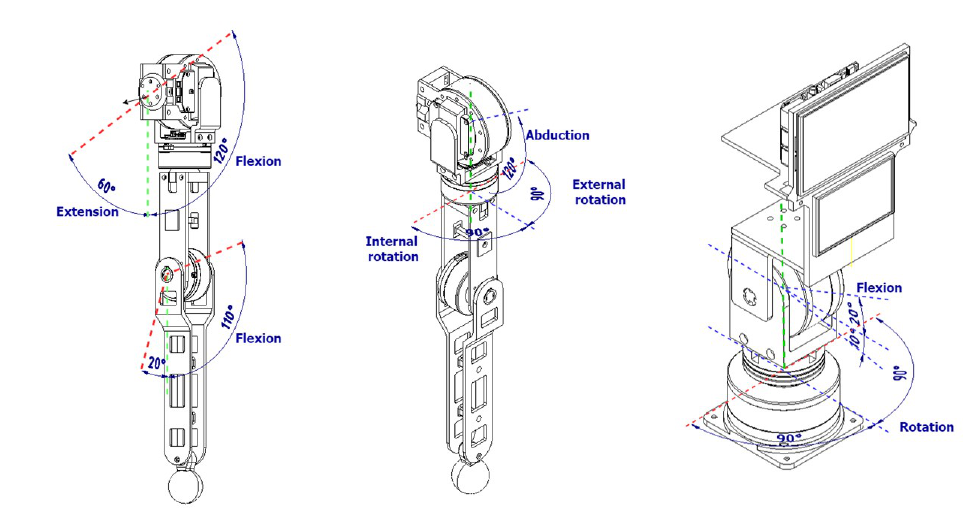
Figure 6. Movement capabilities of the integrated system.